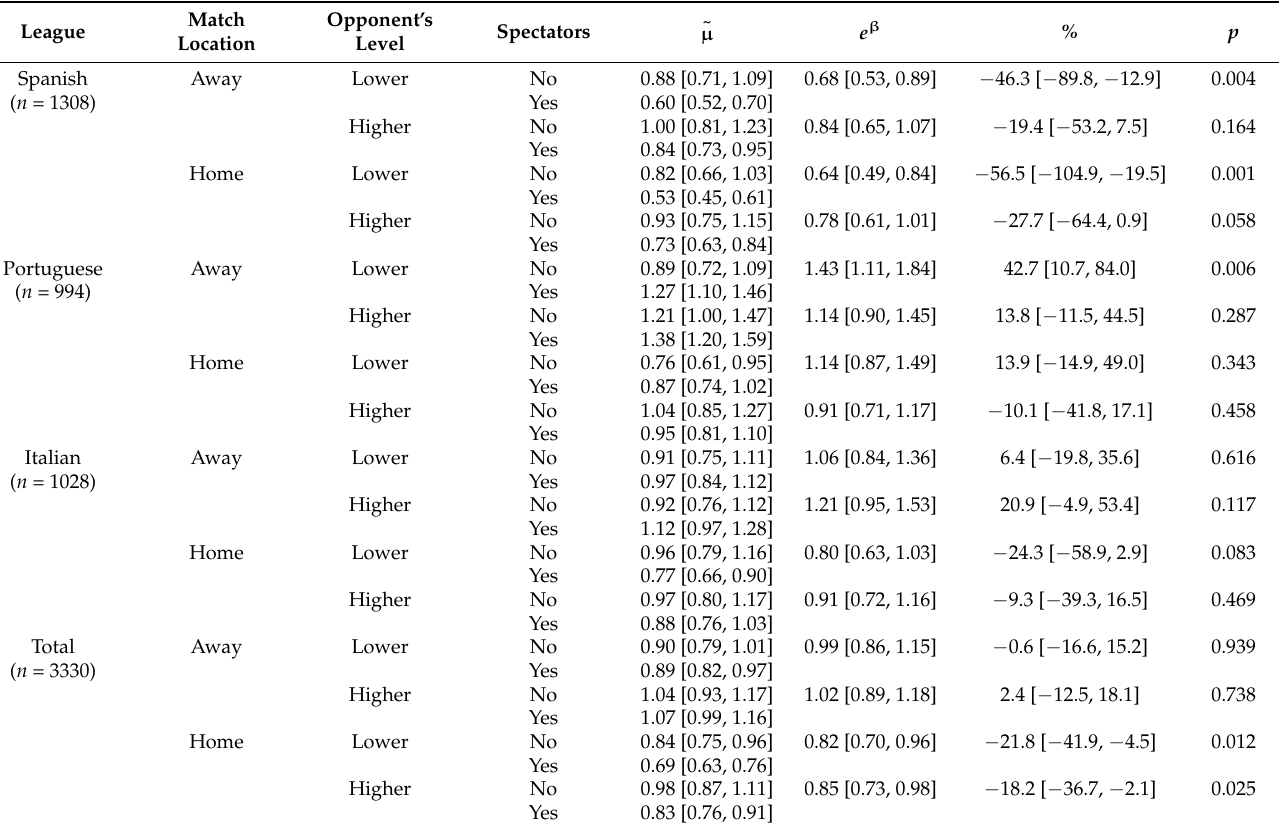
Table 6. Effect of playing with spectators on the number of cards received in different leagues and competitive